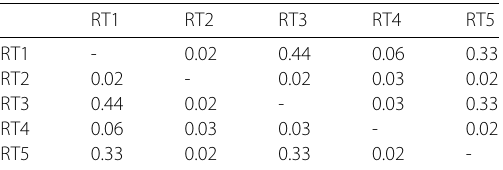
Table 2 P-values of community-pairwise Mann-Whitney tests for the data shown in Fig. 1(c). Wherever p < 0.05 we can reject the null hypothesis of the test and state that the distributions of URLs between the two communities are statistically different RT1 RT2 RT3 RT4 RT5 RT1 - 0.02 0.44 0.06 0.33 RT2 0.02 - 0.02 0.03 0.02 RT3 0.44 0.02 - 0.03 0.33 RT4 0.06 0.03 0.03 0.02 RT5 0.33 0.02 0.33 0.02